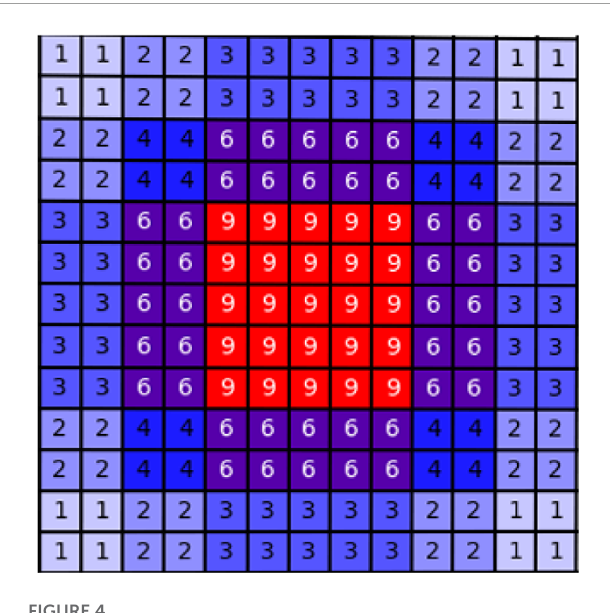
FIGURE 4 Schematic diagram of the receptive field of the dilated block. The numbers in the grid represent the number of